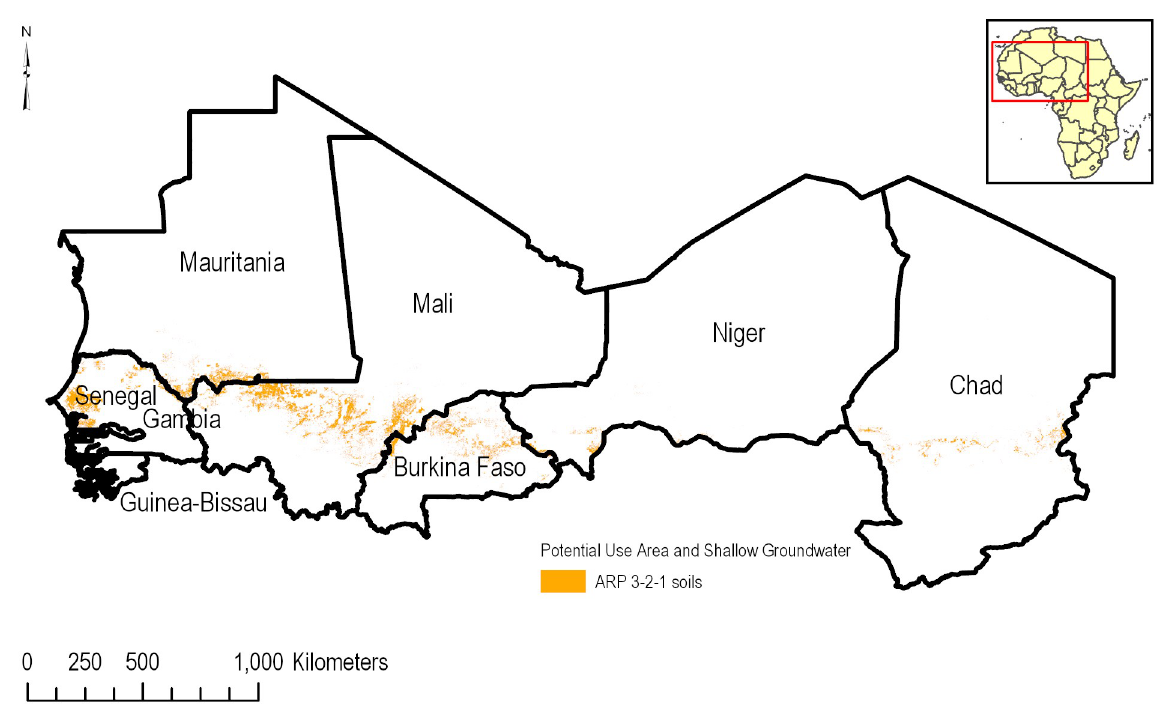
Fig 11. Spatial distribution of the ARP 3-2-1 soils in the PUA overlapping shallow groundwater.